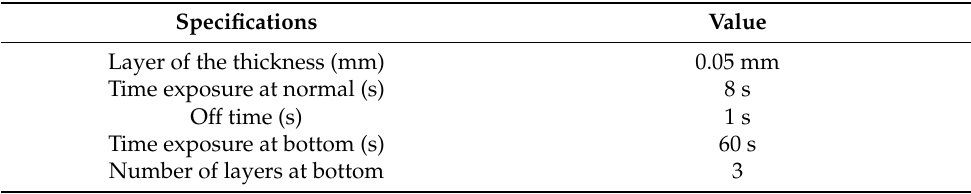
Table 2. The optimized printing setting for PHB/PUA blends resin.